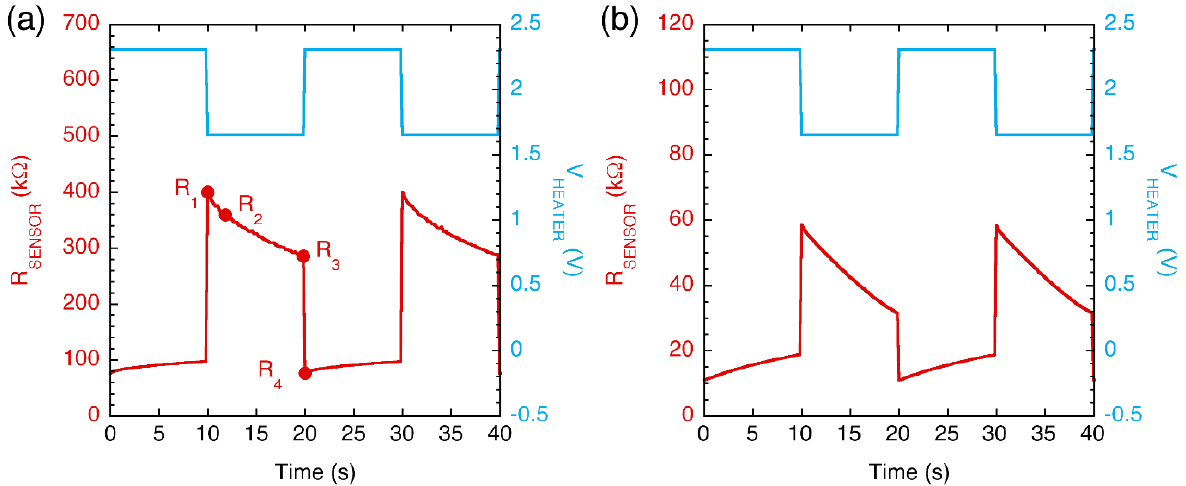
Figure 2. Sensor resistance vs. time curves acquired during sensor exposure to air ( a ) and to the headspace of a fish sample at the storage time of 14 h ( b ). In both cases, experiments were carried out inside the refrigerator (4 °C). The modulation of the heater voltage is also shown. Full circles in ( a ) indicate the resistance values used to extrapolate parameters (features) that resume the shape of the curve (see text for details).